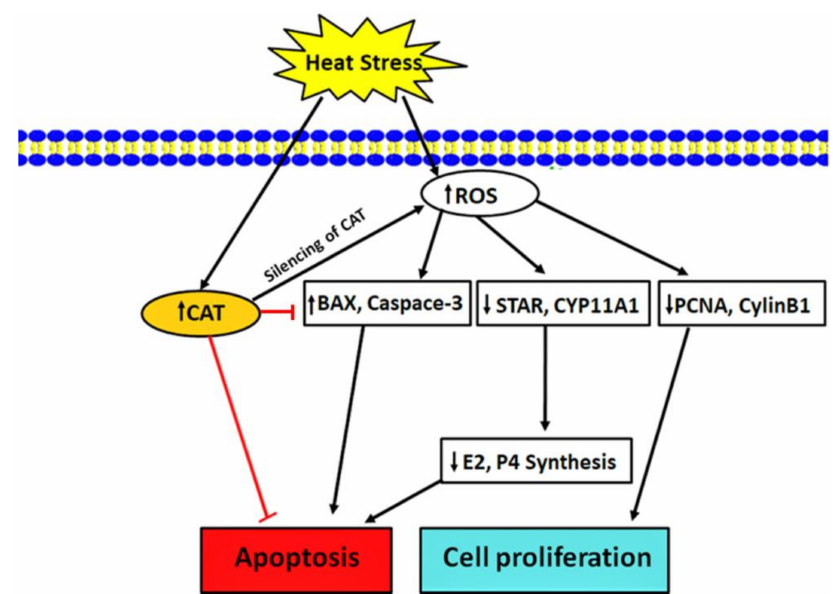
Figure 9. The mechanism of CAT regulating GCs apoptosis and cell proliferation under HS. Under HS, CAT prevents apoptosis by down-regulating the expression of BAX and Caspase-3, while the silencing of CAT induces ROS production and subsequently a ff ects the level of E2 and P4 in GCs by regulating the STAR and Cyp11A1 genes, altering cell proliferation by down-regulating the PCNA and CyclinB1